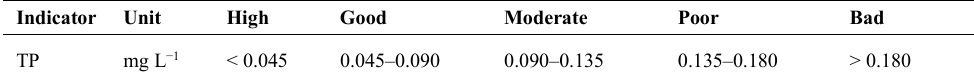
Fig. 9. Scatterplot of the TP losses (kg ha -1 ) vs. water discharge Q (mm) in the Berze, Mellupite and Vienziemite small catchment scale. T ABLE 3. L IMITS OF P HYSICO -C HEMICAL Q UALITY C LASSES FOR R IVER T YPE